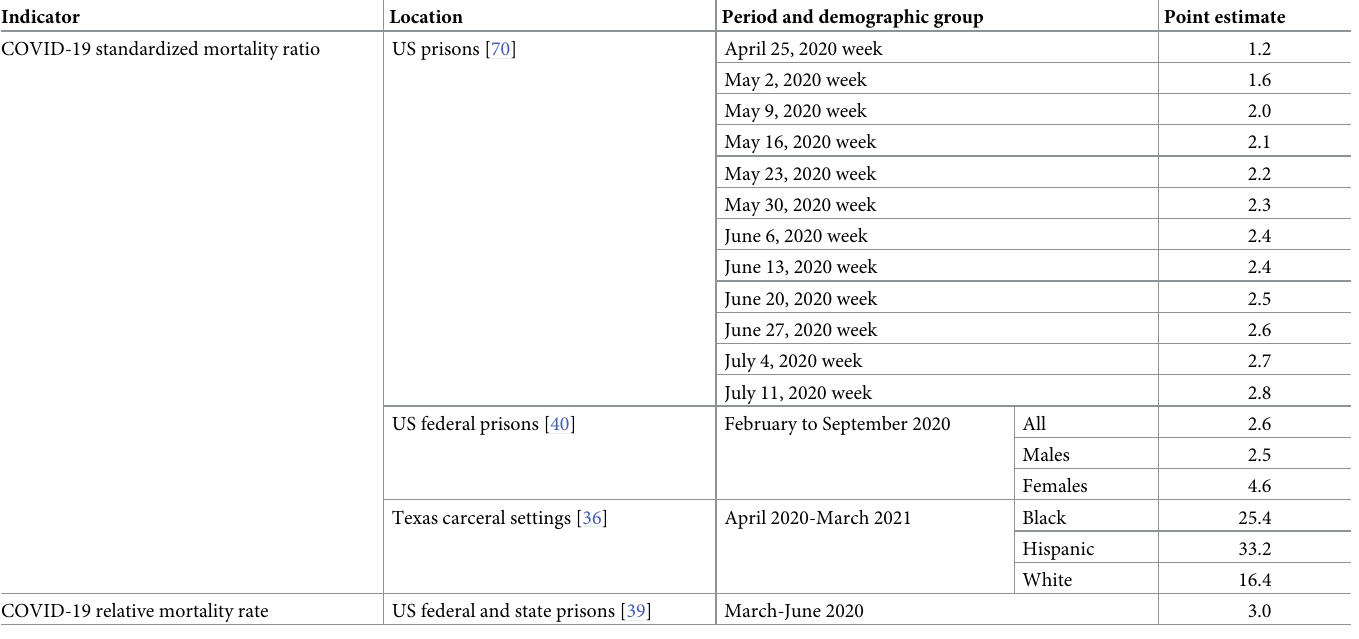
Table 3. Estimates of COVID-19 mortality for people in prison relative to the general population, controlling for age and sex, in studies included in a systematic review on the health impacts of the COVID-19 pandemic on people who experience imprisonment a